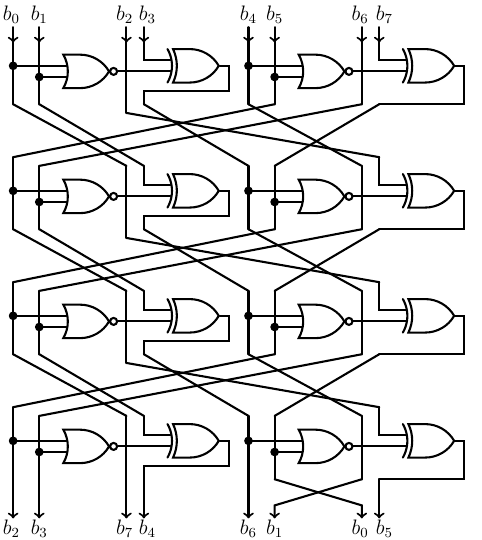
Figure 11: The 8-bit Sbox used in Skinny-128 (from [Jea16])